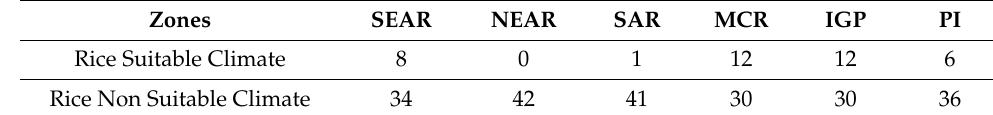
Table 12. Rice Suitable Climate Year Score for 42 years (1980–2021) for various rice producing zones.